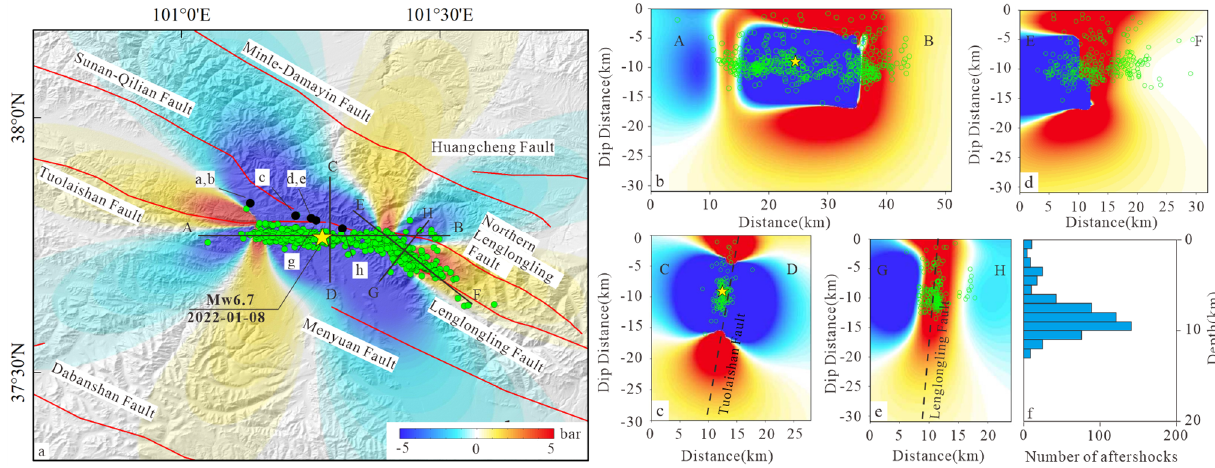
Figure 7. Aftershocks and Coulomb stress distribution of the 2022 event.